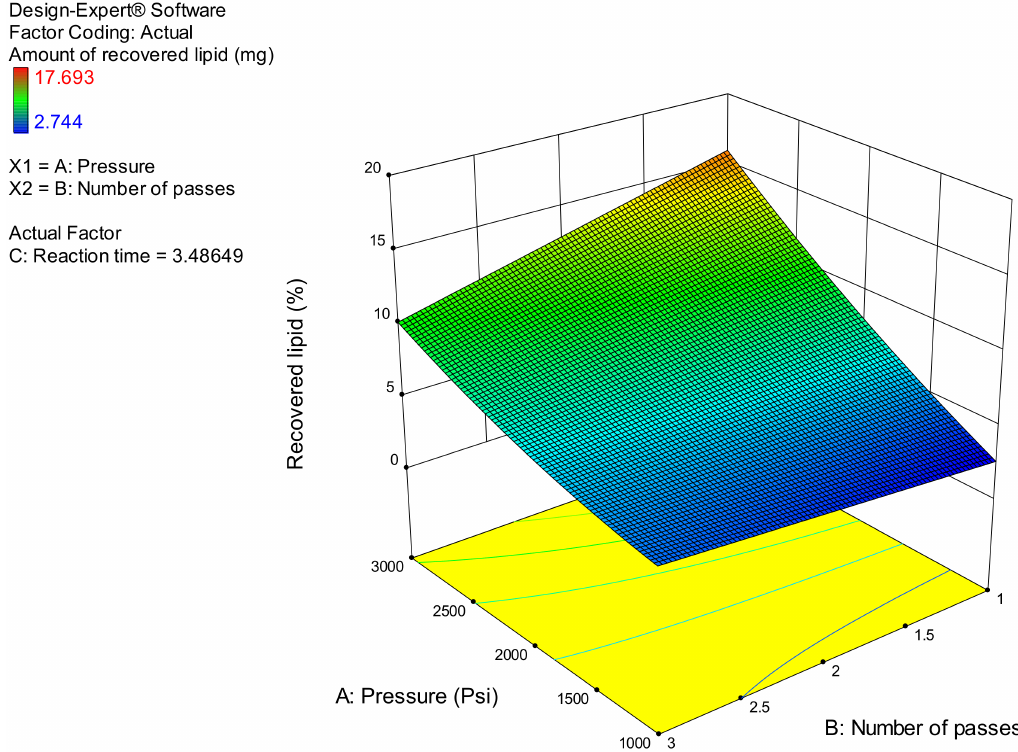
Figure 4. Response surface plot in 3D for Pressure and Number of passes for the percentage of lipid